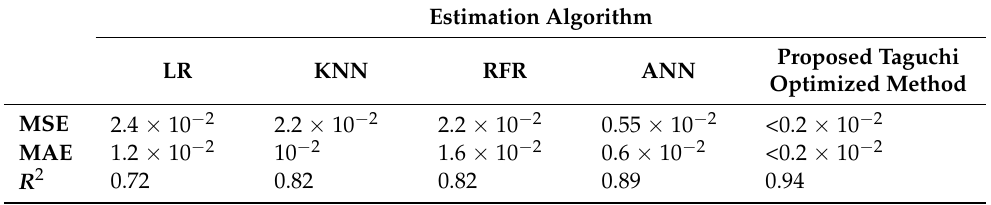
Table 7. Comparison of the proposed method with the different prediction algorithms.